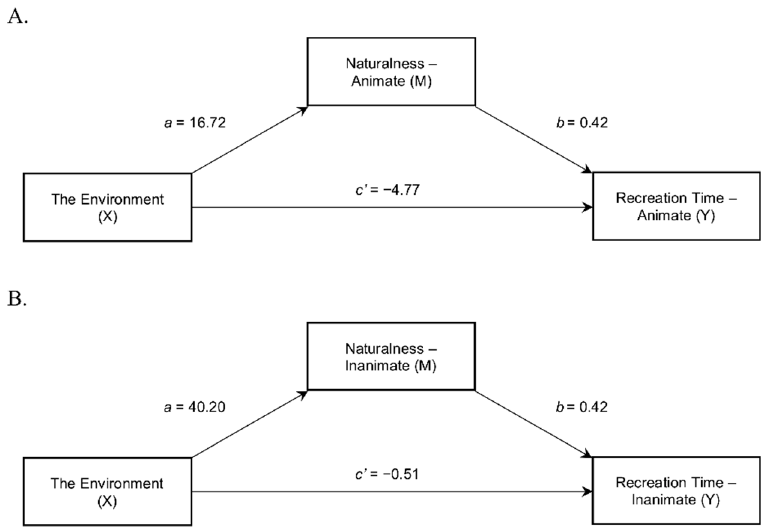
Figure 3. Indirect effect of the environment on recreation time via the naturalness of the environments for environments with animate ( A ) and inanimate soundscapes ( B )—statistical diagrams containing regression coefficients.